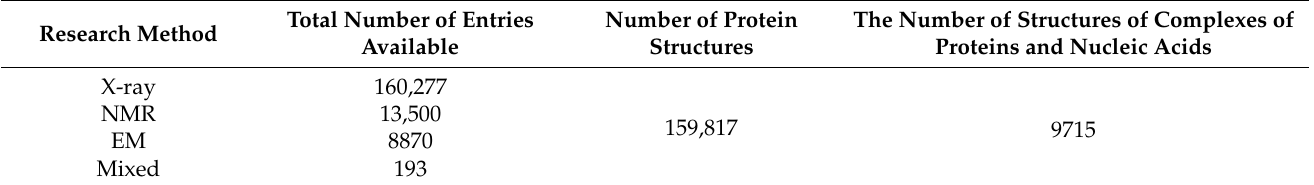
Table 2. Composition of annotated protein structures in the Protein Data Bank database (https://www.rcsb.org/stats/ growth/growth-xray accessed on 5 October